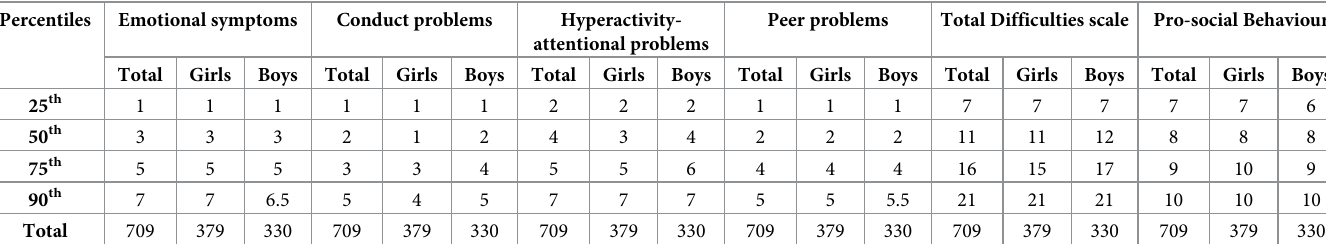
Table 7. Normative data for total scores by sex based on adolescent self-report, age group 9–11.